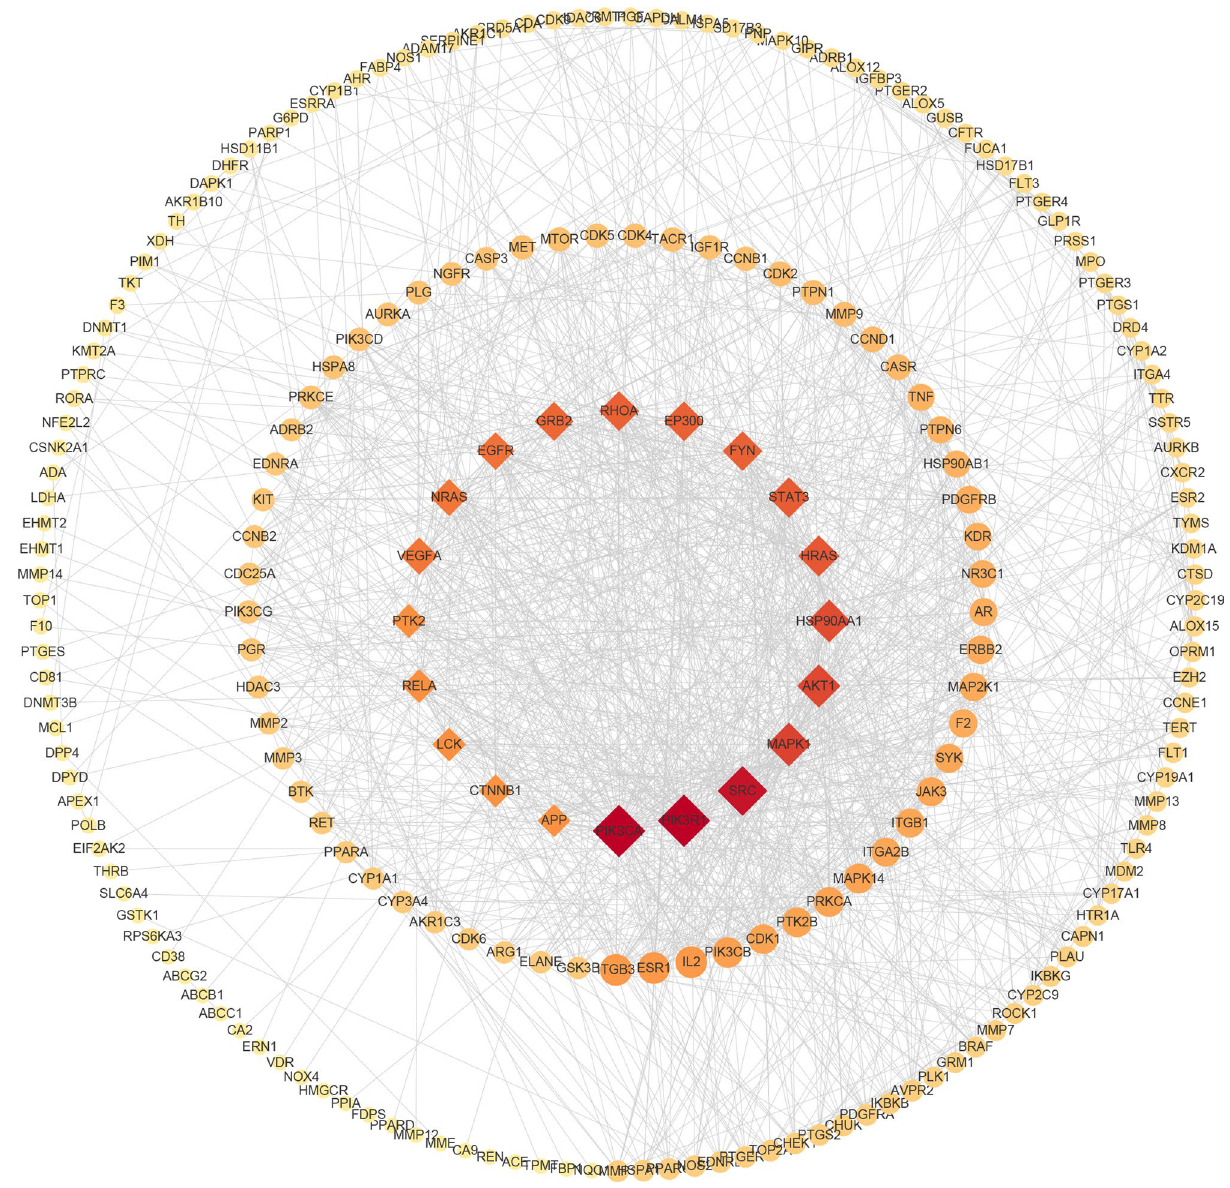
Figure 4. Protein–protein interaction (PPI)